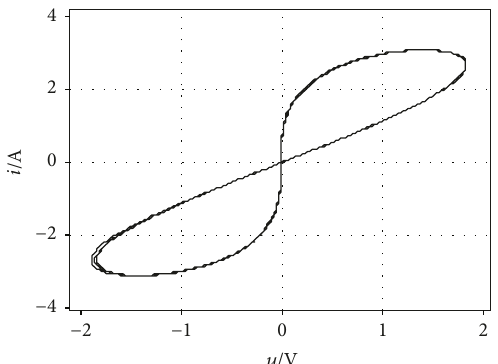
Figure 2: Volt-ampere characteristic curve of the passive charge- controlled